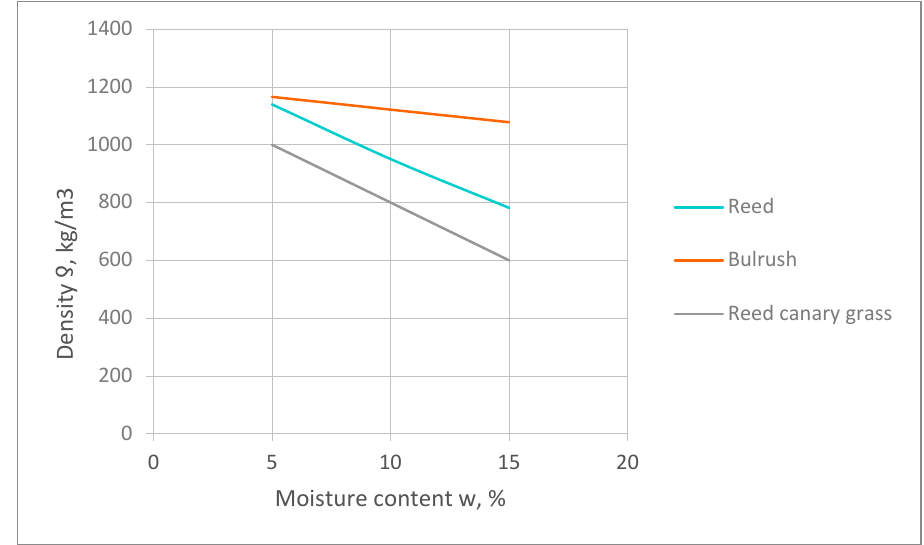
Figure 2. Density dependence on moisture.